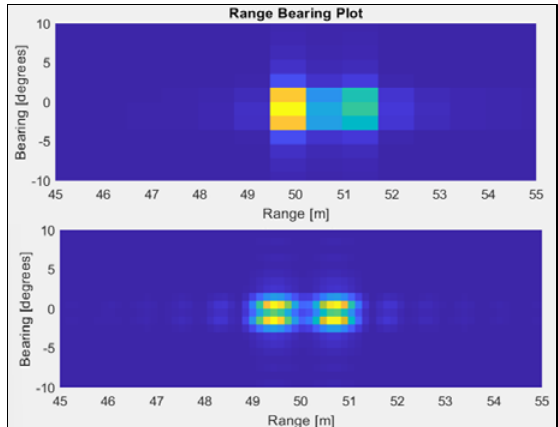
Fig. 8. Resolution Comparison: (above) 3D FFT Method (below) Proposed